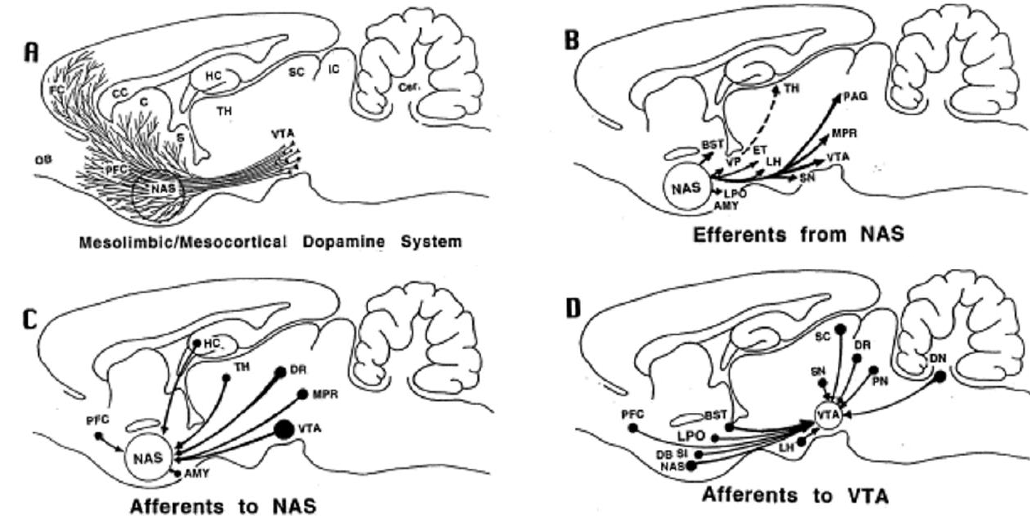
Figure 2. Mesocorticolimbic reward circuitry of the rat brain. ( A ) Ascending projections of dopamine (DA) neurons (localized in the VTA) innervating to limbic regions including the nucleus accumbens (NAS, the mesolimbic DA system) as well as cortical regions (the mesocortical DA system); ( B ) Major efferent projections of the NAS; ( C ) Afferent projections to the NAS; ( D ) Afferent projections to the VTA. Abbreviations — AMY, amygdala; BST, bed nucleus of stria terminalis; C, caudate – putamen; CC, corpus callosum; DA, dopamine; DB, diagonal band of Broca; DN, dentate nucleus; DR, dorsal raphe; ET, entopeduncular nucleus; FC, frontal cortex; HC, hippocampus; IC, inferior colliculus; LH, lateral hypothalamus; LPO, lateral preoptic area; MPR, mesopontine reticular nuclei; OB, olfactory bulb; PAG, periaqueductal gray; PFC, prefrontal cortex; PN, parabrachial nucleus; SC, superior colliculus; SI, substantia innominata; SN, substantia nigra; TH, thalamus; VP, ventral pallidum. Adapted from [27], permissions obtained.